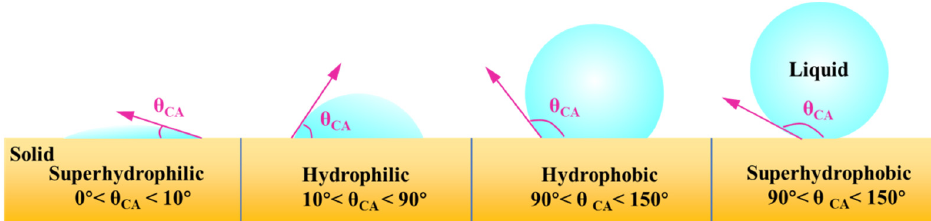
CA ), ( b ) Rolling angle ( θ RA ).